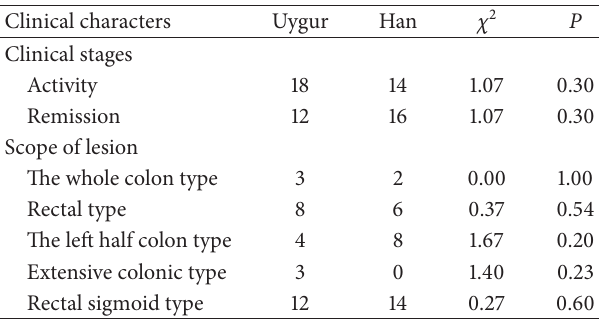
Table 2: The clinical stages and the scope of lesion in the case and control